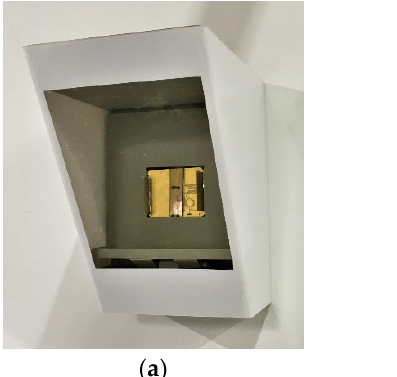
Figure 4. Possible solution for the installation of two cooperative readers in a typical indoor scenario. Additionally, two possible positions of the tag are represented (blue, on a shoulder; red, on the belt) [46]. The device and its associated elaboration unit (Raspberry Pi 3) were included in the wall light, as shown in Figure 5a, in order to be as minimally invasive as possible.